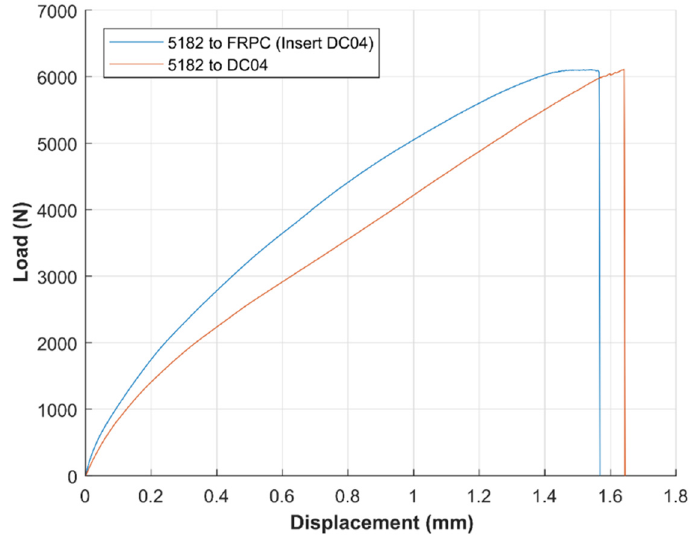
Figure 15. Quasi-static lap shear typical curves comparison between joints of 5182/FRPC (insert DC04) and MPS welded 5182/DC04 joints under the same conditions.